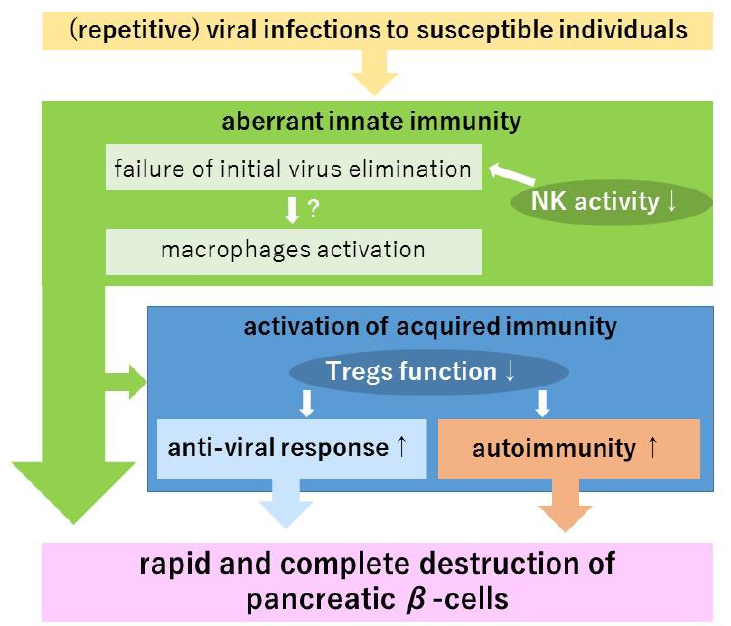
Figure 2. Aberrant immune response leading to pancreatic β -cell destruction in fulminant type1 diabetes (FT1D) (hypothesis). The development of FT1D following flu-like symptoms suggests the importance of aberrant innate immune responses. Decreased natural killer cell (NK) activity has been reported in FT1D patients, suggesting failure of initial virus elimination. Histopathologically, the marked infiltration of macrophages into pancreatic islets is observed. In mouse models, macrophages are considered to be the major factor in pancreatic β -cell destruction. Furthermore, T cell infiltration into pancreatic islets was observed in histopathological tissue. Repetitive enterovirus infections in FT1D patients suggests the existence of acquired immunity against virus-infected cells. In addition, the fact that islet-associated autoantibodies were positive in some cases suggests the existence of autoimmunity. The decreased regulatory T cell (Treg) activity shown in FT1D patients, and this aberrant innate immune response may make antiviral immunity and autoimmunity more